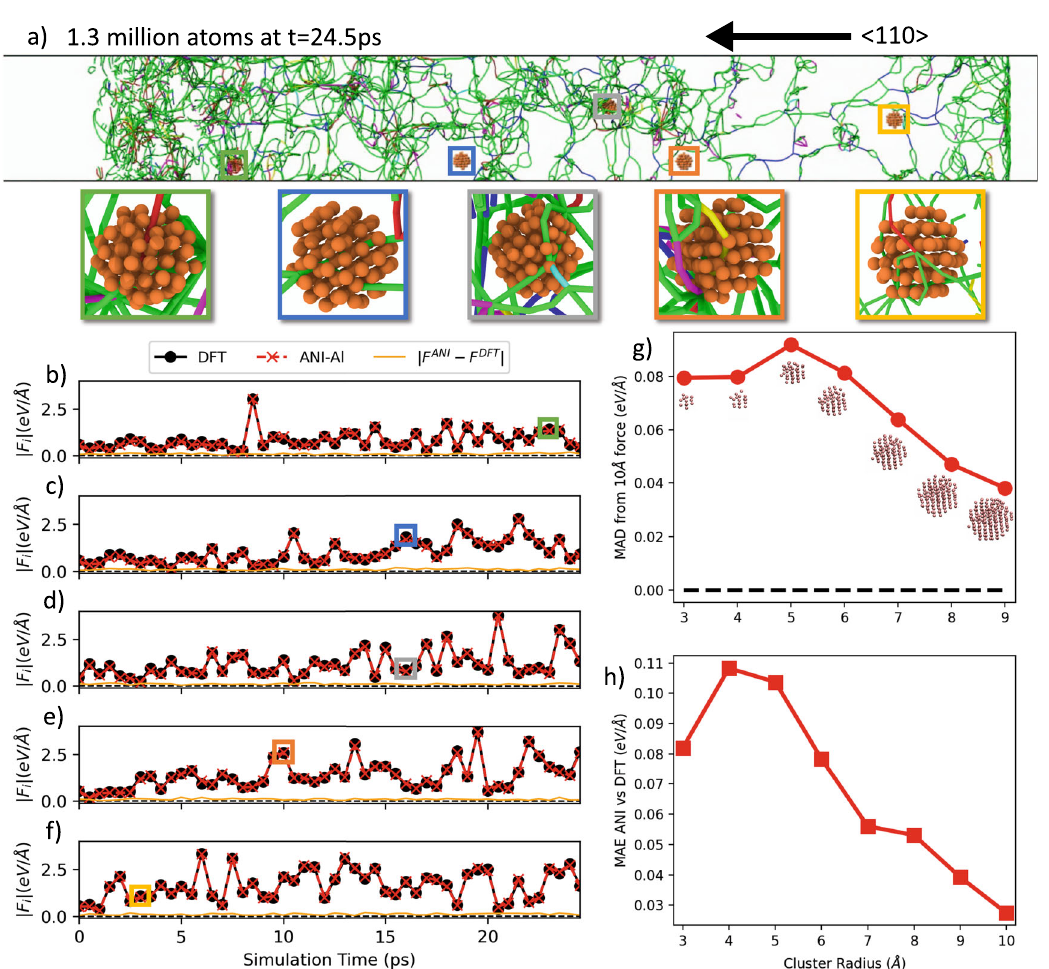
Fig. 7 A 1.3 million atom shock simulation using the ANI-Al potential. A shock of 1.5 km/s was initiated from the right along the 〈 110 〉 crystallographic direction. a Dislocation structure calculated using OVITO after 24.5 ps of simulation as well as zooms for fi ve randomly selected atoms at hand-picked times. b – f Veri fi cation of the ANI-Al force predictions for these fi ve atoms every 0.5 ps. Reference forces were obtained by performing new DFT calculations for small clusters centered the fi ve atoms. g Comparison of DFT-calculated forces on the central atom for varying cluster radius (reference force calculated at radius 10 Å ). h Mean absolute error of ANI-Al predicted forces, relative to DFT, as a function of cluster radius.